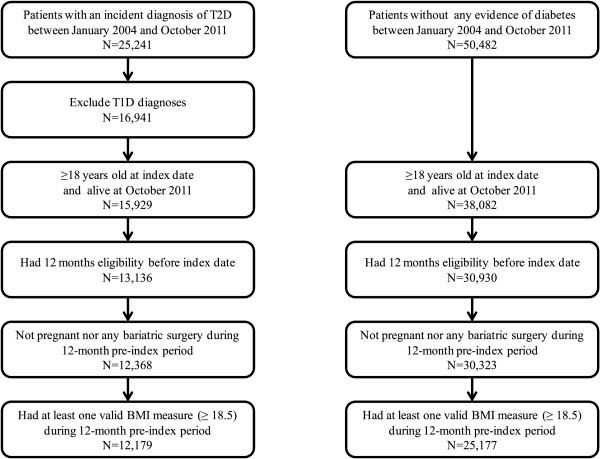
Sample Selection.